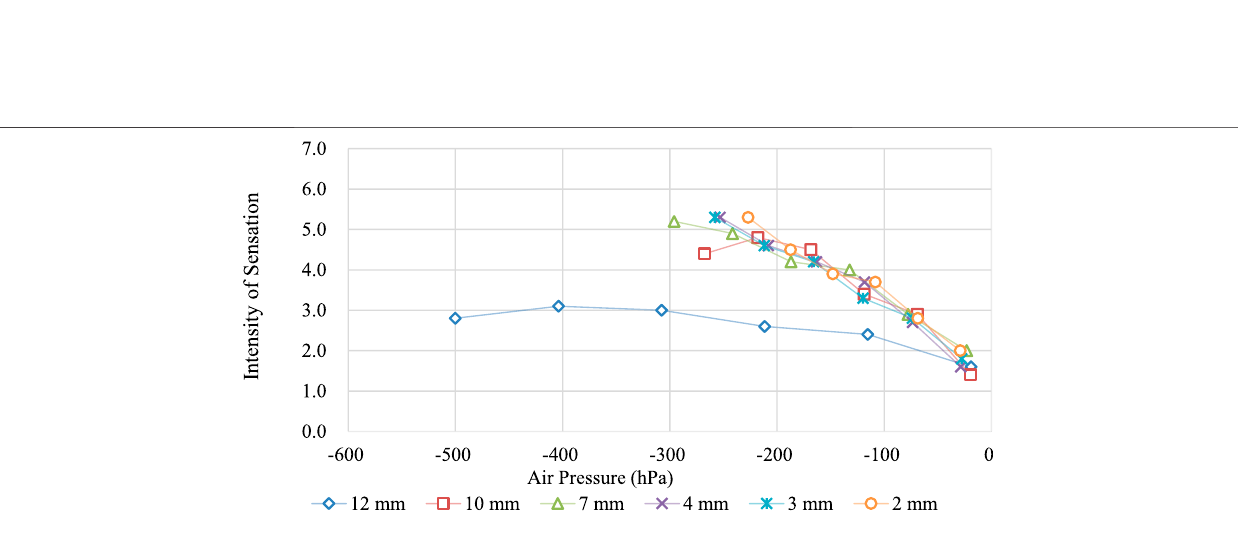
FIGURE 8 | Perception of tactile intensity with different suction diameters and pressures.